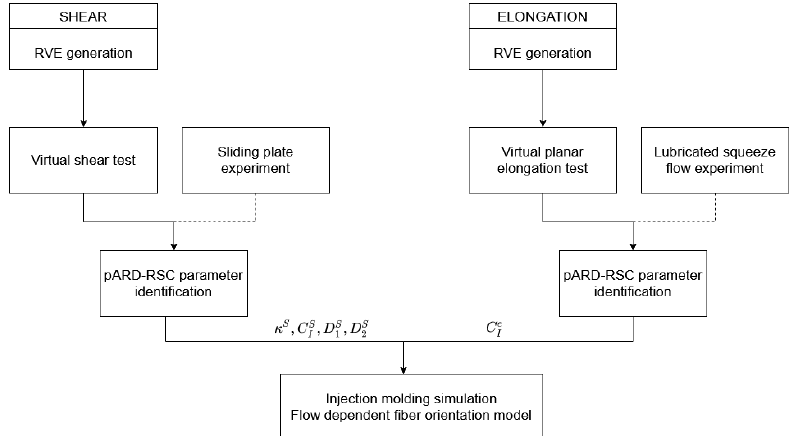
Figure 12. Workflow for parameter identification of the flow-dependent fiber orientation model.